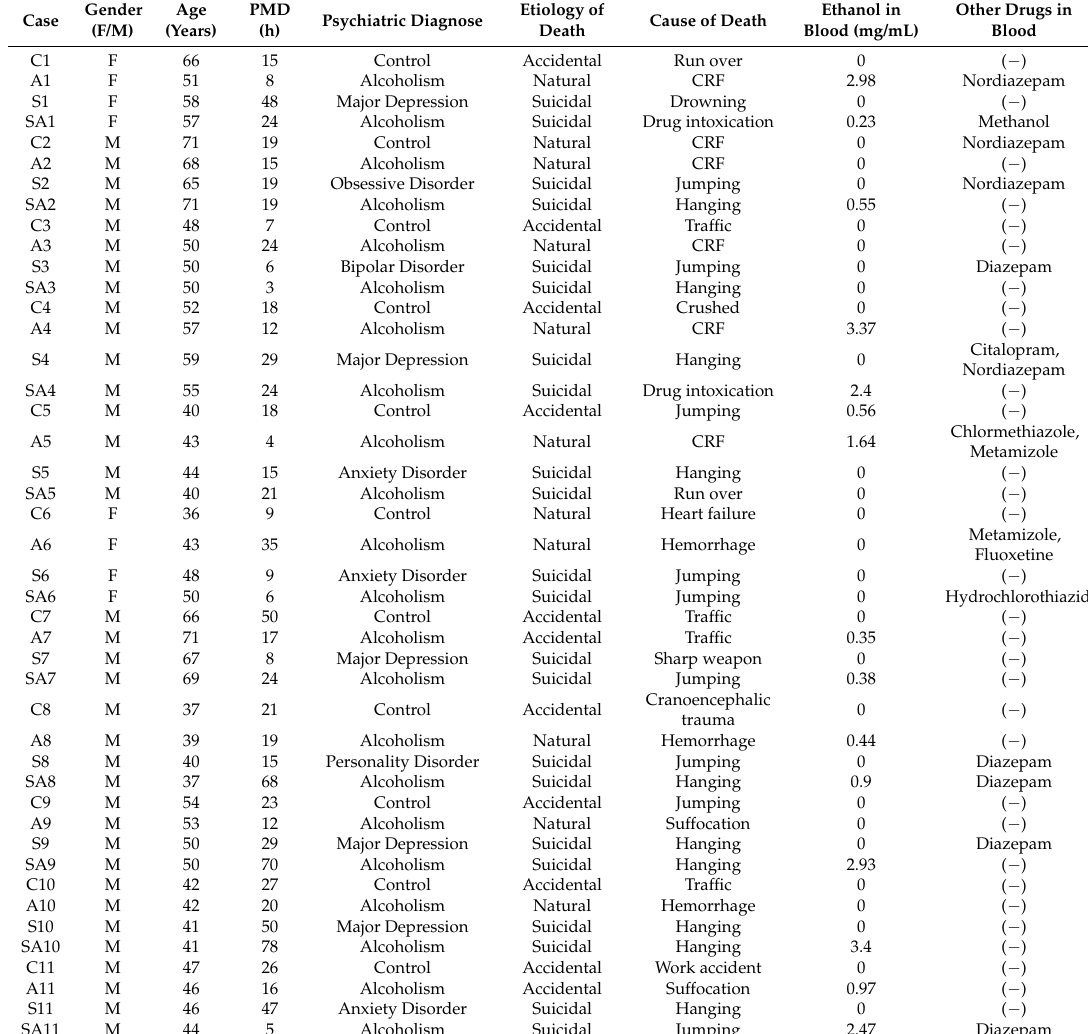
Table 1. Demographic characteristics, post-mortem delay (PMD), psychiatric diagnosis, cause of death, and toxicological characteristics of control (C), alcoholic (A), (non-alcoholic) suicide (S), and suicide alcoholic (SA) subjects.